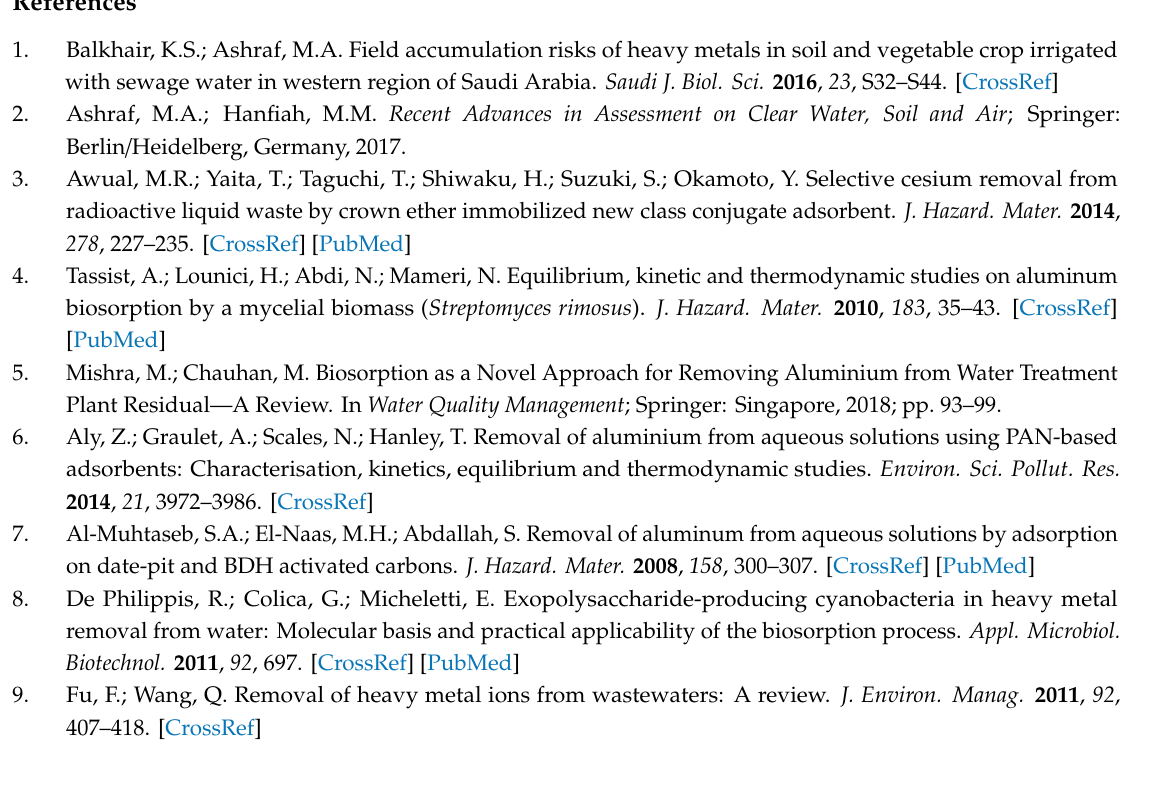
Figure S1: Synthesis and Characterization of Natural Extracted Precursor Date Palm Fibre-Based Activated Carbon for Aluminum Removal by RSM